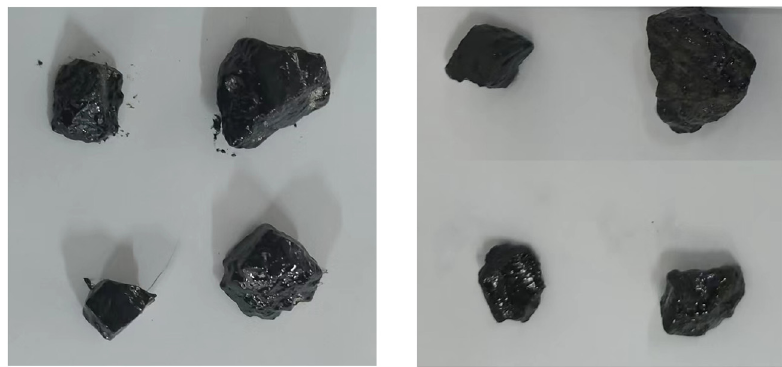
Figure 21: Boiling test: ( a ) before boiling and ( b ) after boiling.